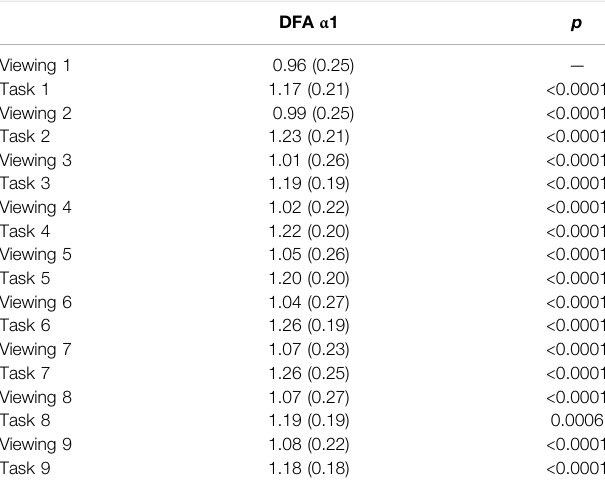
TABLE 4 | DFA α 1 2-minute comparison during Phase I. p -values are reported in comparison with previous activity. All numbers except p -values are presented as mean